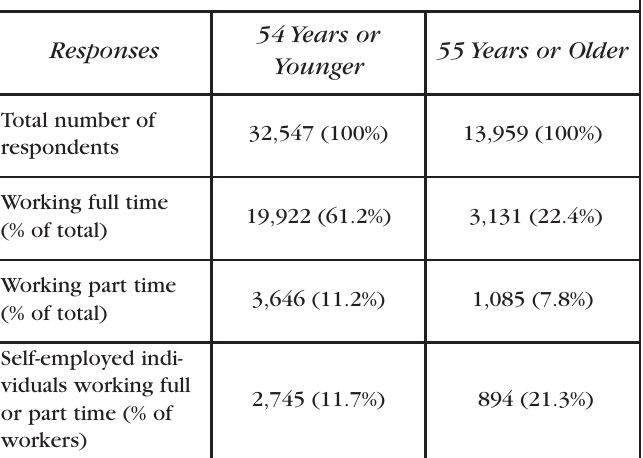
Table 2. Summary of